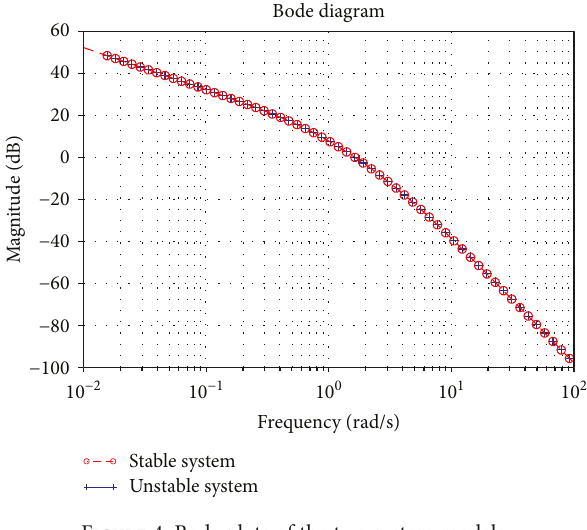
Figure 4: Bode plots of the two system